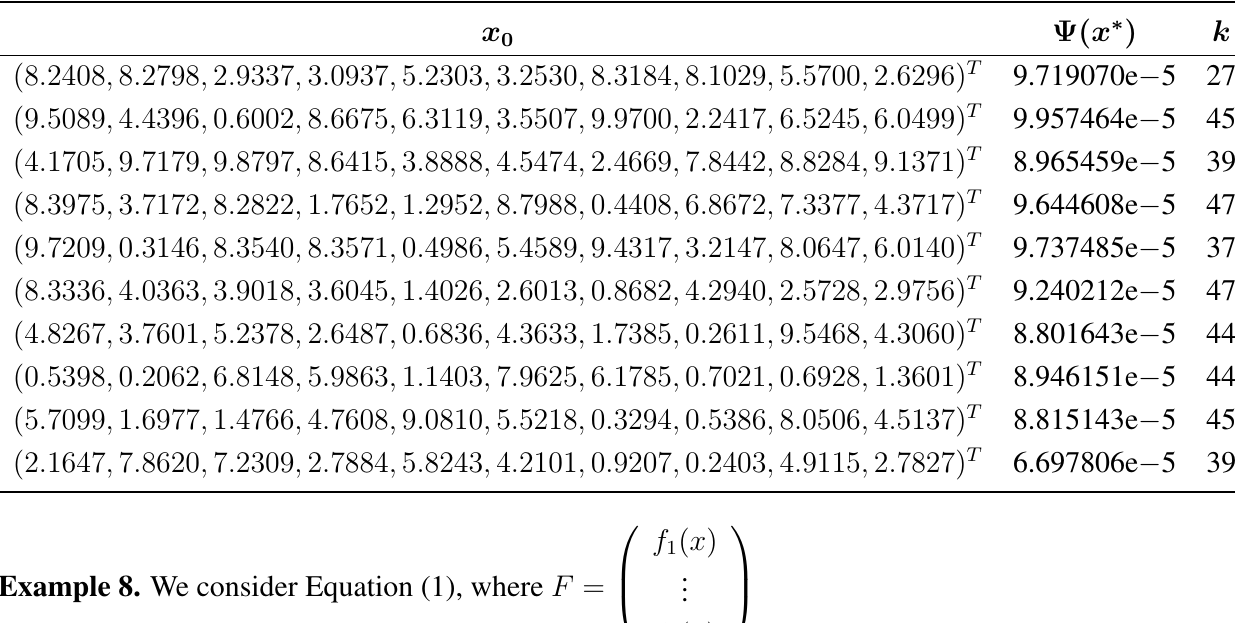
Table 7. Number of iterations and the final value of Ψ( x ∗ ) .